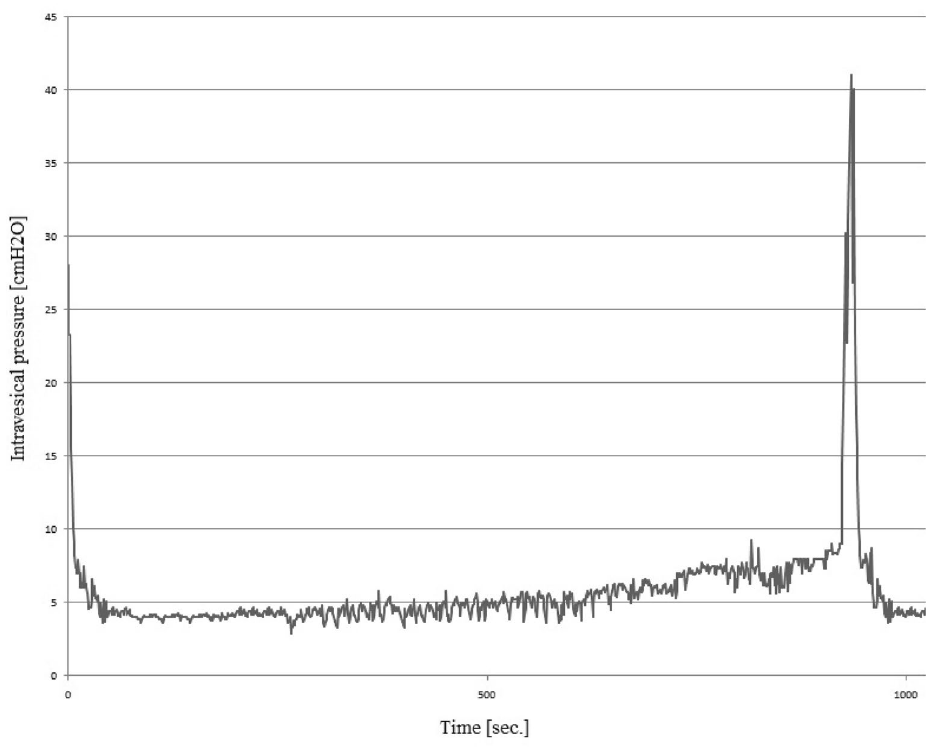
Figure 3. Cystometrogram in rats with cyclophosphamide (CYP)-induced detrusor overactivity after Potentilla chinensis extracts administration. The figure shows a 1000-s interval (horizontal axis). The vertical axis is the intravesical pressure (range: 0–45 cmH 2